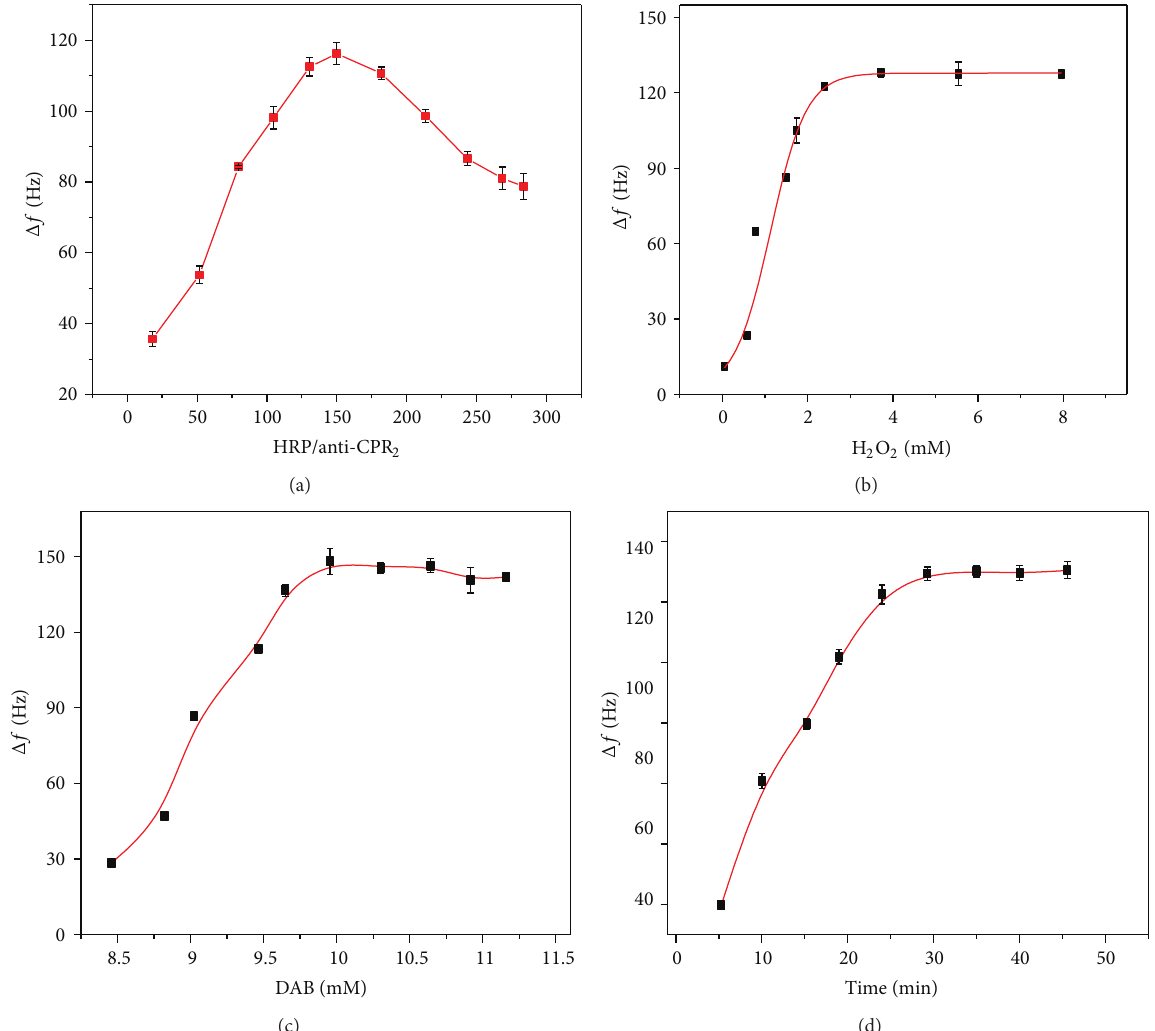
Figure 7: (a) Optimization of volume ratio of HRP to anti-CRP2 for preparation of Fe-Au MNPs-anti-CRP2/HRP. Effects of concentration of (b) H 2 O 2 , (c) DAB, and (d) incubation time on the signal response at the